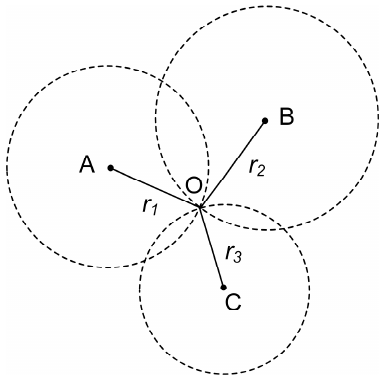
Figure 1. Theoretical map of the trilateration positioning method.